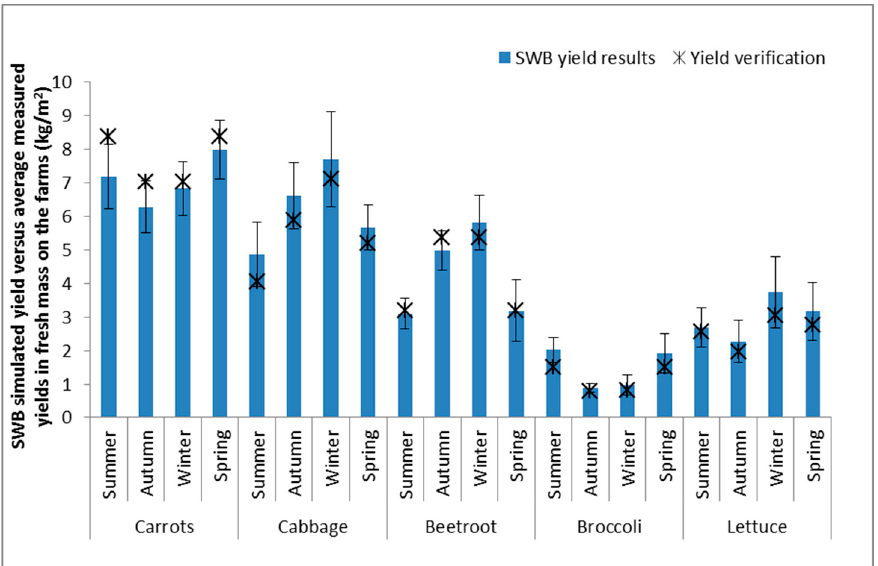
Figure 5. Average of 10 years’ simulated seasonal yields (2004–2013) with standard deviations (shown as error bars) of vegetable crops for the different growing seasons compared to measured fresh mass yield data from the farms on the Steenkoppies Aquifer.